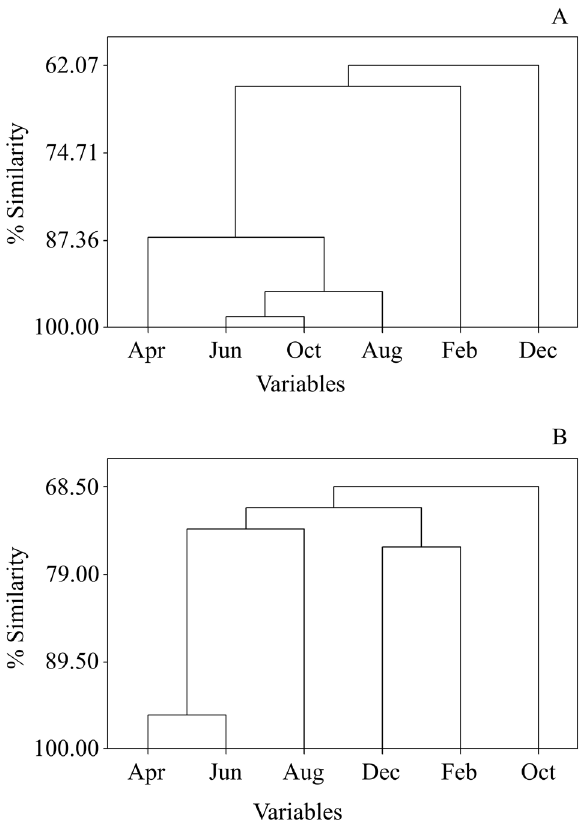
Fig 3. Similarity dendrogram based on the percentage data of (A) the 52 pollen types in pollen pots and (B) the 50 pollen types in honey pots of Melipona subnitida